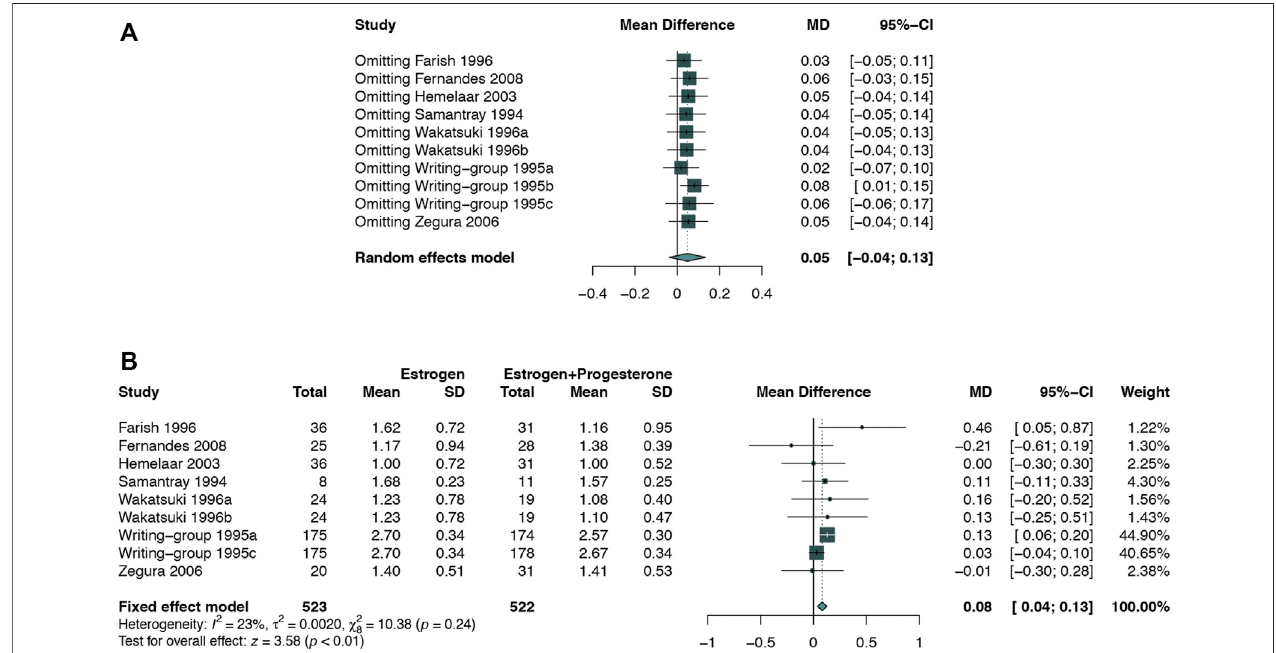
FIGURE 10 | Sensitivity analysis for TG in the subgroup of estrogen alone vs. E + P regimen. Sensitivity analysis suggested that while omitting one group of the study Writing − group 1995b, E + P group cause a signi fi cantly higher TG (WMD: 0.08 mmol/L, 95% CI: 0.01 – 0.15 mmol/L) than Estrogen alone. (A) Sensitivity analysis; (B) forest plot after omitted study Writing − group